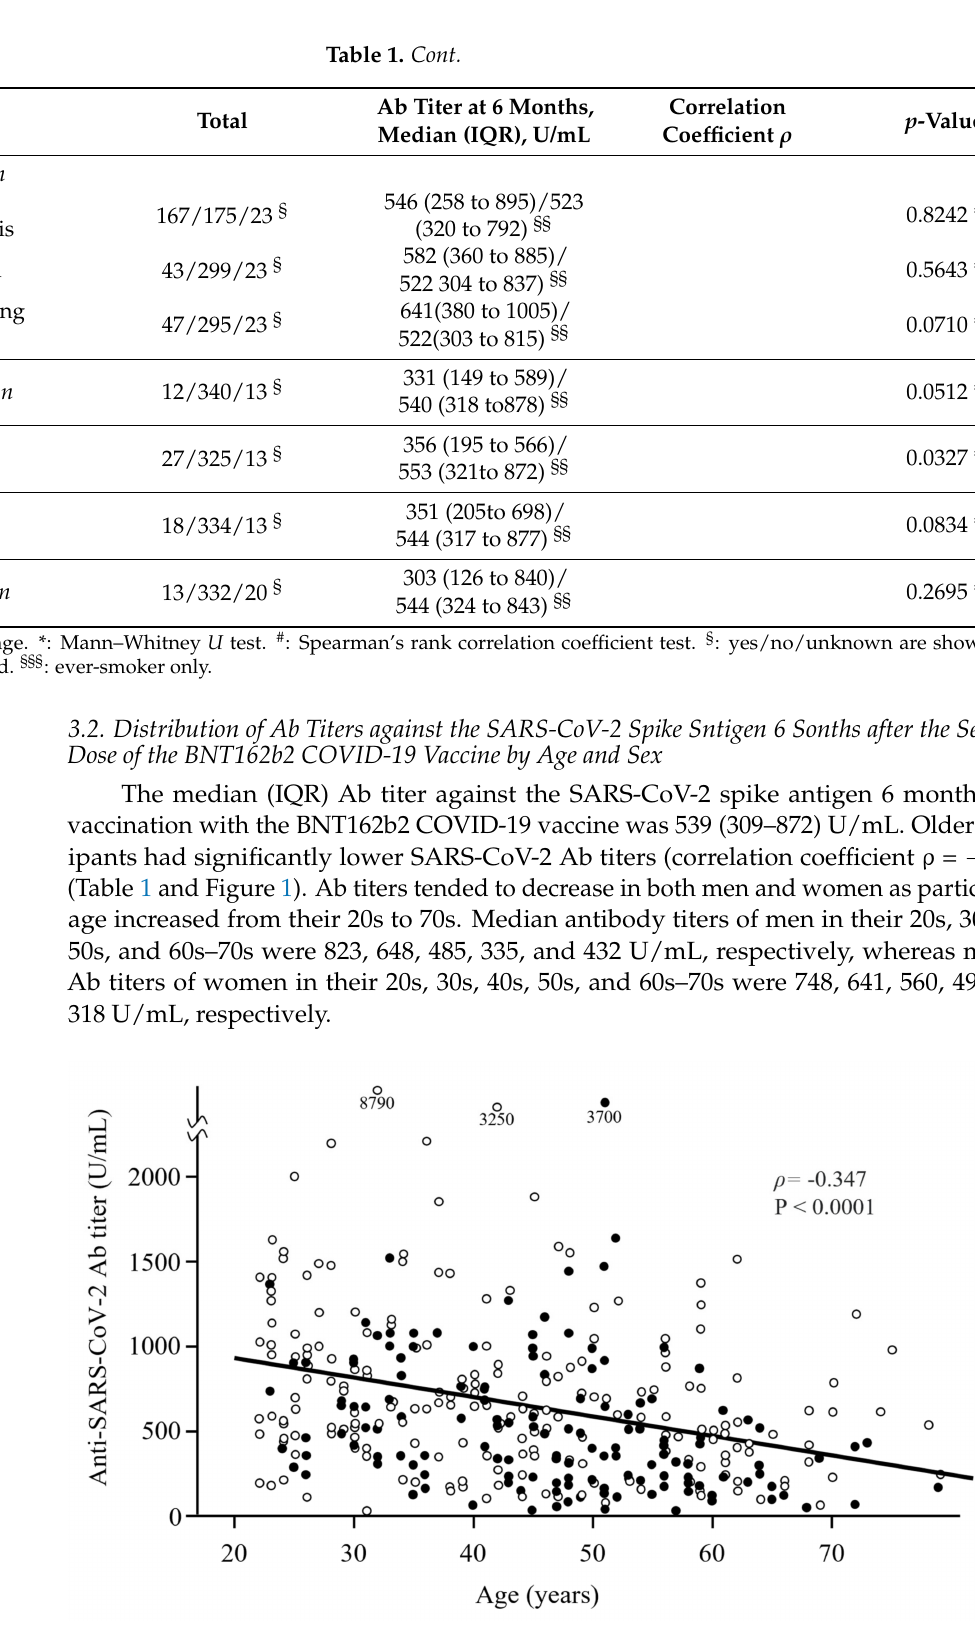
Figure 1. Scatter plot of the distribution of Ab titers 6 months after the second vaccine dose according to age and smoking status. Older participants had significantly lower Ab titers. Closed and open circles show ever-smokers and never-smokers, respectively. Ever-smokers had lower Ab titers than